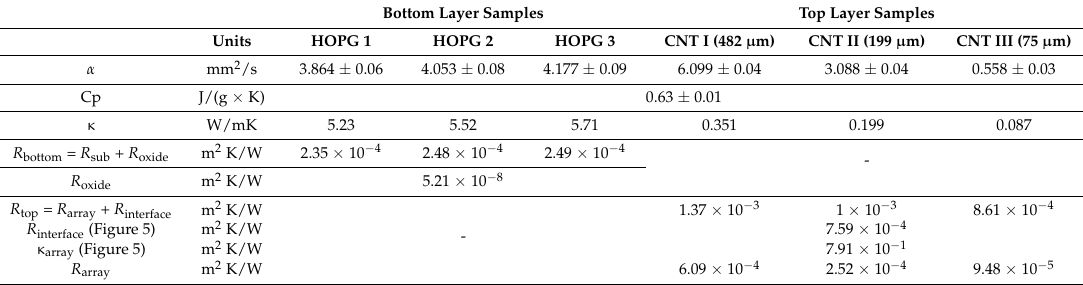
Table 2. Thermal Analysis Results.